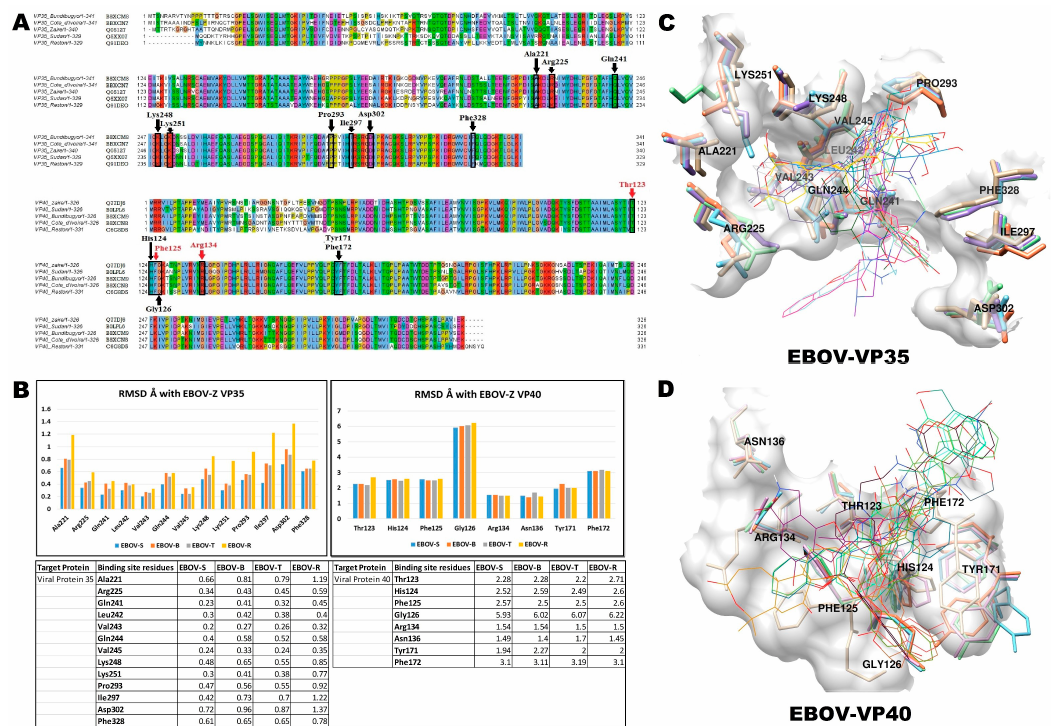
Figure 7. Structural analysis of different Ebola strains. ( A ) Multiple sequence alignment of viral protein 35 (VP35) and 40 (VP40) of Ebola Zaire , Reston , Côte d’Ivoire, Sudan and Bundibugyo along with their chain length. Residues are coloured according to default colouring scheme of clustalX. Important structural residues of binding sites of VP35 and VP40 among the five Ebola subtypes are highlighted with a black outline, and labelled by residue name, as indicated by an arrowhead. The red arrowhead indicates RNA interacting residues (Thr123, Phe125 and Arg134) of VP40, which are also conserved among all subtypes. Sequences of representative Ebola virus subtypes were retrieved from GenBank and aligned using ClustalW. The alignment was further hand curated using Jalview 2.7; ( B ) Structural comparisons of conserved binding site residues. Individual RMSD values of conserved binding site residues (VP35 in left, VP40 in right) of all Ebola strains are plotted against the corresponding residues of EBOV-Z. The RMSD analysis shows that binding site residues of EBOV-S, EBOV-R, EBOV-B and EBOV-T contain a close structural similarity with corresponding residues of EBOV-Z; Structural superimposition of VP35 ( C ) and VP40 ( D ) are displayed in the bottom. Amino acid side chains highlight the conserved binding site residues of VP35 and VP40 in all strains as EBOV-Z (tan), EBOV-S (plum), EBOV-T (green), EBOV-B (sky blue), EBOV-R (coral), top ligands (wire form) are docked in the binding site of EBOV-Z. Molecular surface of the EBOV-Z binding site is highlighted in brown.